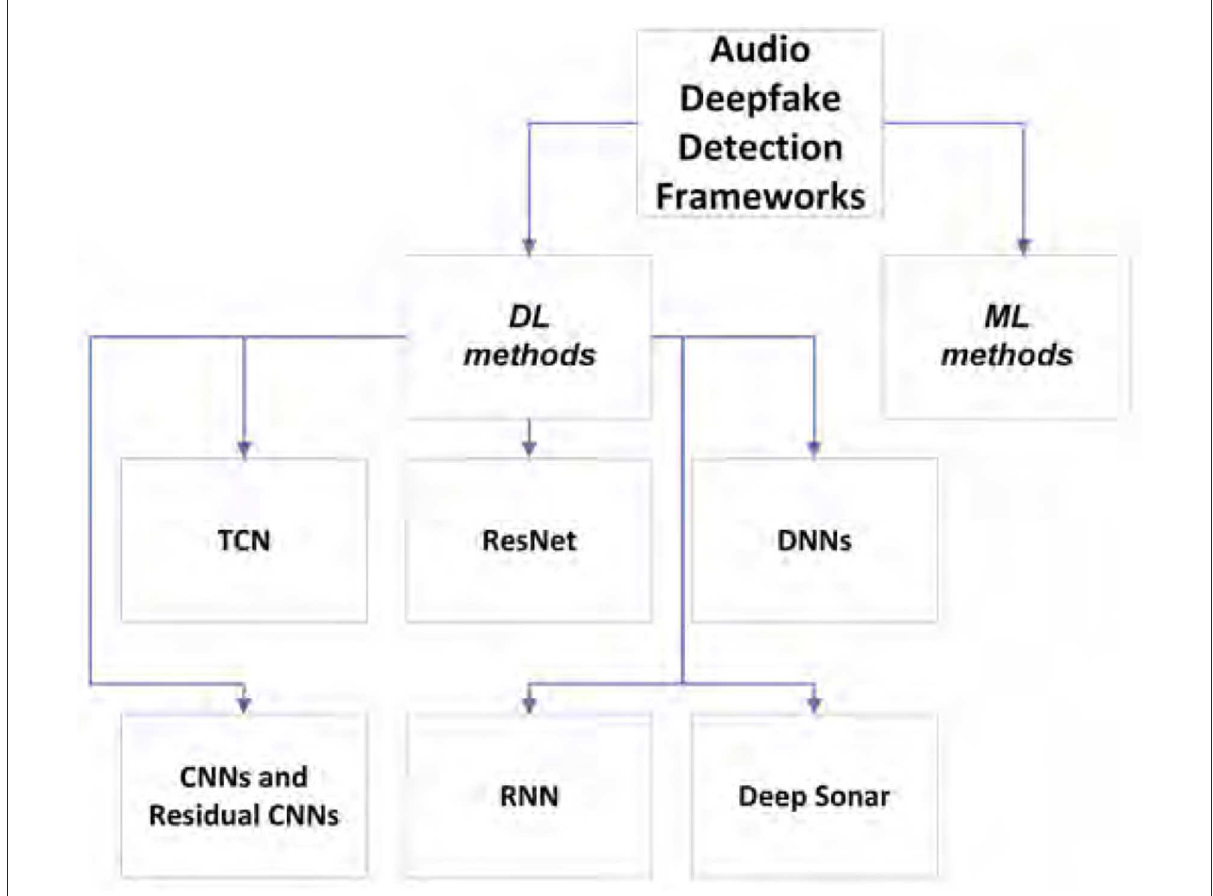
FIGURE2 Audio deepfake detection